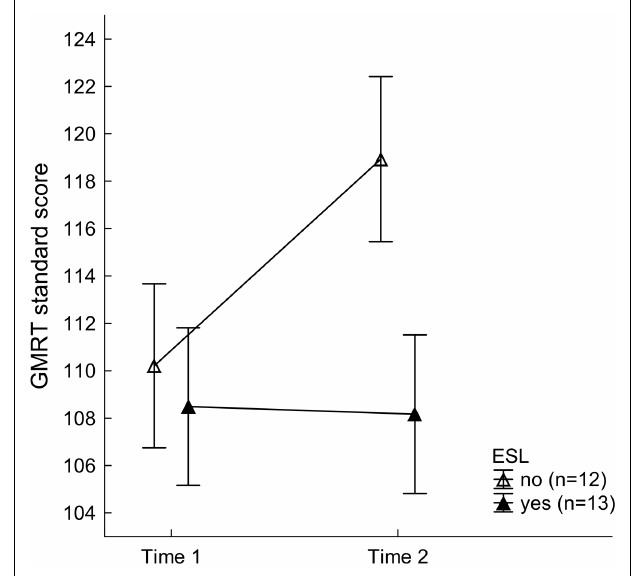
FIGURE 3 | Gates MacGinitie ReadingTest (GMRT) standard scores for the training group as a function of speaking English as a second language (ESL) atTime 1 andTime 2. Mean values of 12 non-ESL (open triangles) and 13 ESL students (filled triangles) are shown.Vertical bars represent standard errors of mean. Non-ESL training participants improved significantly across time and outperformed the ESL students after completion of the intervention